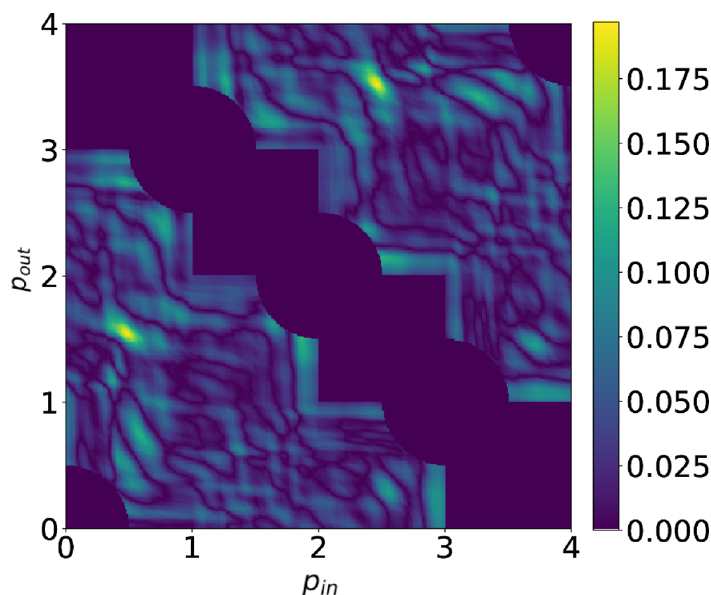
figure 21. Here we exclude from the analysis not only lines along the perimeter of the field of view but also any line of length less than 0.5; in the heatmap such lines are assigned ¯Γ[ C ] = 0 by default.